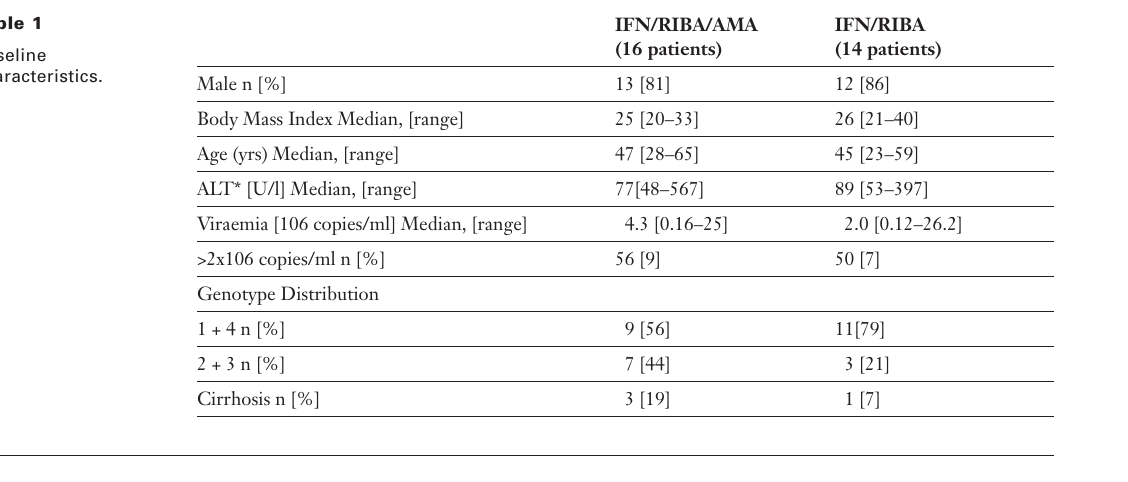
Table 2 Number of adverse